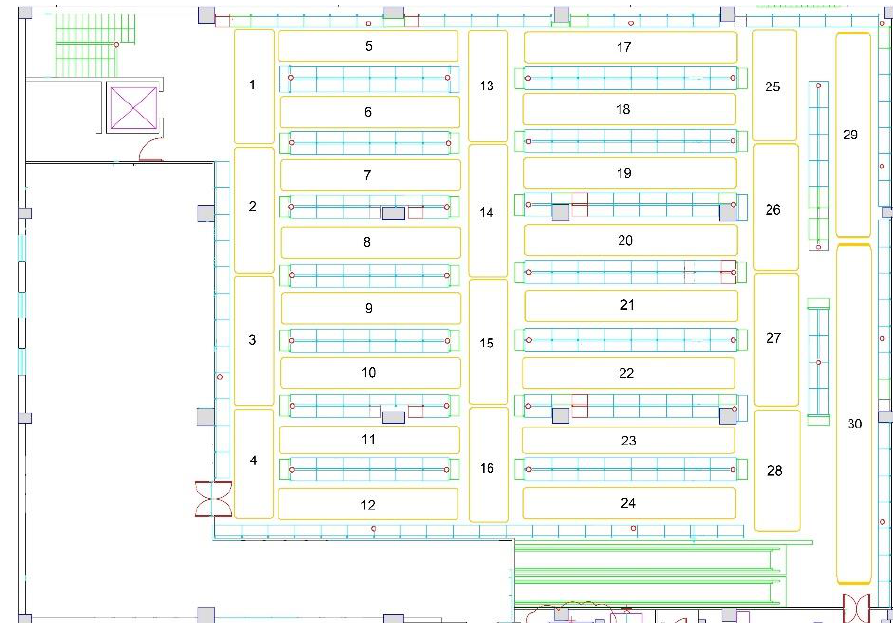
Figure 4. Map of the BLE beacon-enabled first floor of the grocery store (store areas are labelled with a number from 1 to 30, beacons are presented in red circles).